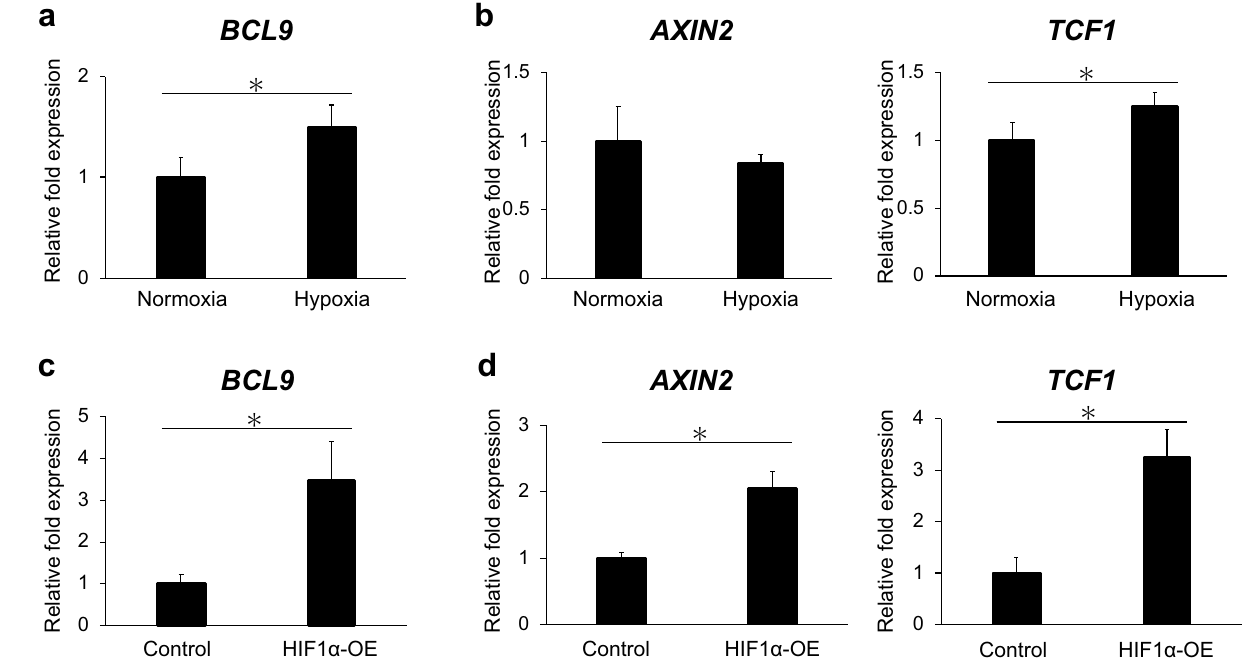
Figure 3. Hypoxia and HIF1α upregulate BCL9 mRNA expression and promote Wnt/β-catenin signaling in hDPSCs. ( a , b ) The mRNA expression of BCL9 and Wnt/β-catenin target gene (TCF1) is upregulated in hypoxic culture (1% O 2 ) for 48 h. ( c , d ) The mRNA expression of BCL9 and Wnt/β-catenin target genes (AXIN2 and TCF1) is upregulated by HIF1α overexpression for 48 h. Error bars indicate standard deviation (n = 4). *p <